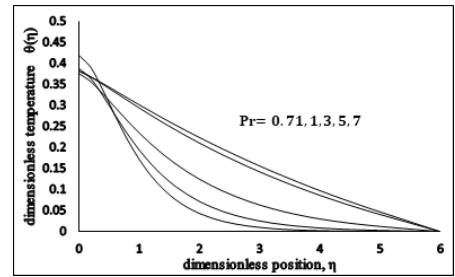
Figure 8. Dimensionless Temperature vs Pr .